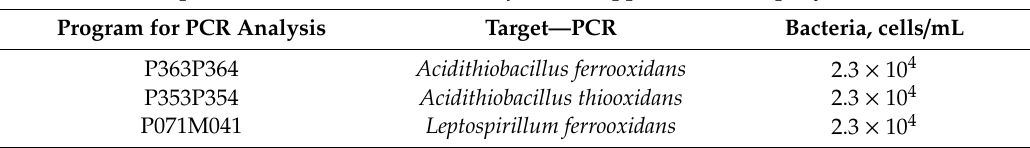
Table 2. Quantification of microbial population using